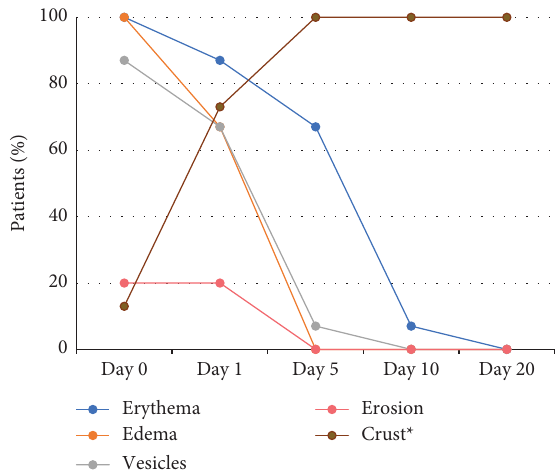
Figure 1: Evolution of the lesion stages during the treatment period of the study for the HSV-1 group (herpes labialis). Te chart shows the proportion of patients with a corresponding type of lesion over a period of 20 days. ∗ Crust stage includes beginning of crust formation to the crust falling of.